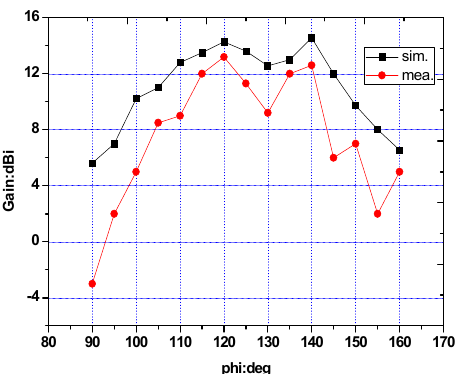
Figure 7. Simulation and test data for the cylindrical reflector antenna at 59 GHz.